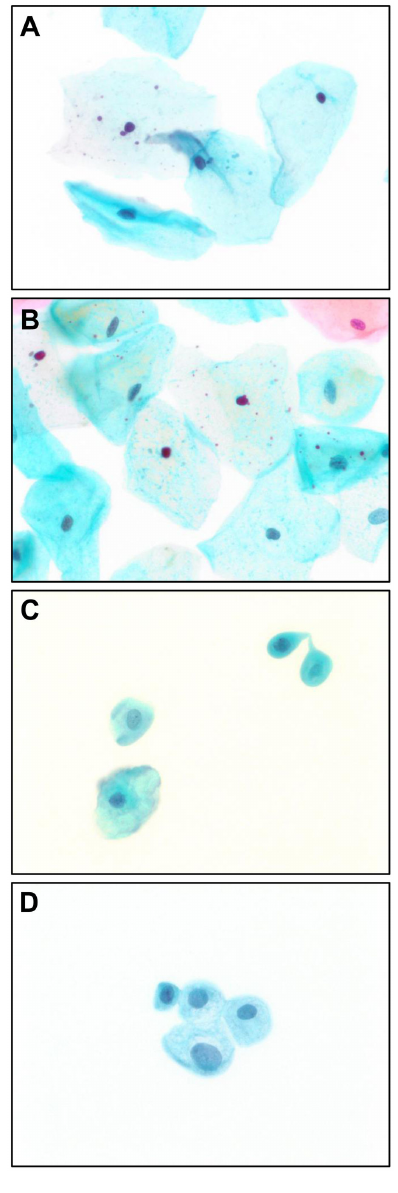
Figure 1. Newborn and 12 week urogenital cells collected from swab and urine specimens (female). A, Newborn Swab: Two superficial cells, characterized by small, dark, pyknotic nuclei and abundant cytoplasm in top right and left sides. Two intermediate cells, with slightly larger oval nuclei and more open chromatin patterns, are present in the middle and lower left. B, Newborn Urine: Two superficial cells, with small, pyknotic nuclei, are located in the center of the field. Most of the remaining cells are intermediates. C, 12-week Swab: Parabasal cells (upper right) and intermediate cells (lower left) are noted. Superficial cells were seen only rarely in this specimen. D, 12-week Urine: A cluster of four cells with parabasal to intermediate features. The cells show no features of superficial cells, which were completely lacking in this